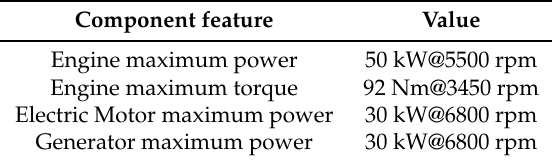
Table 4. Powertrain components.